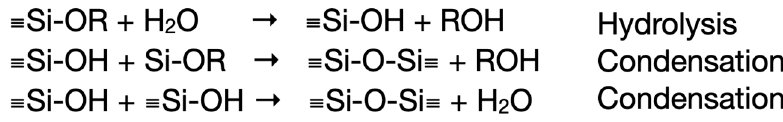
Figure 2. The process of hydrolysis and condensation using a silicon alkoxide.